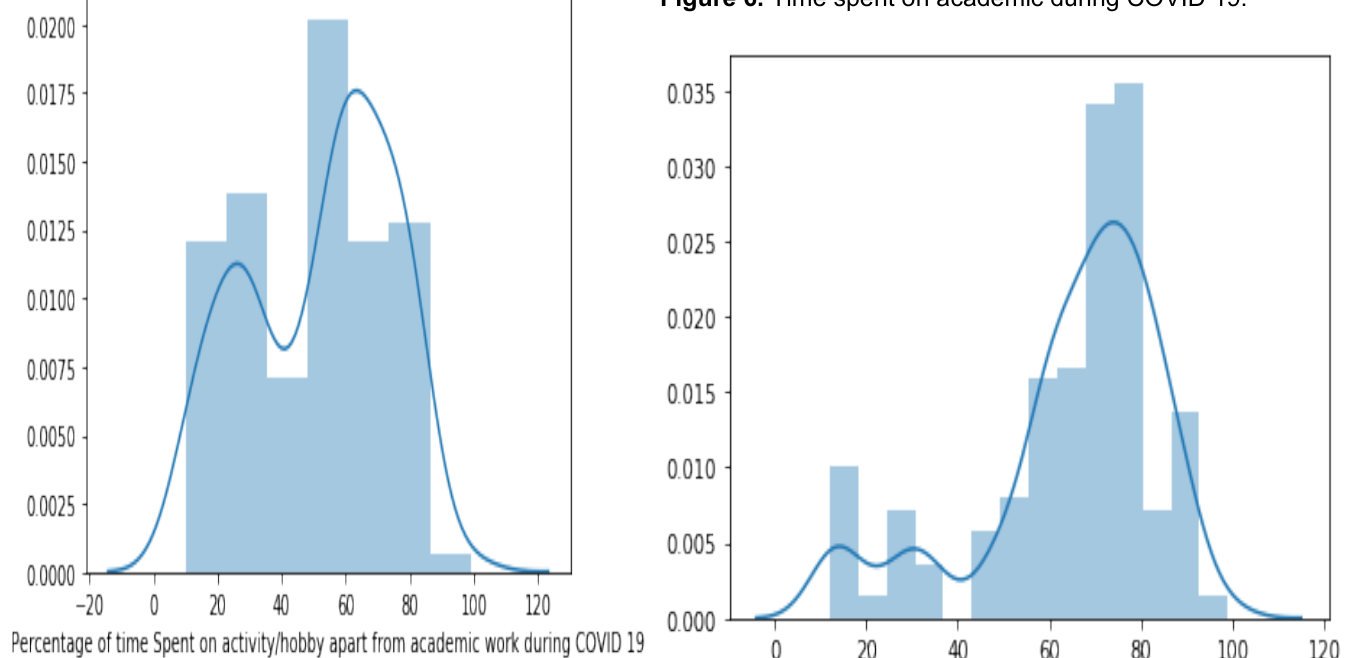
Figure 6. Time spent on academic during COVID 19.